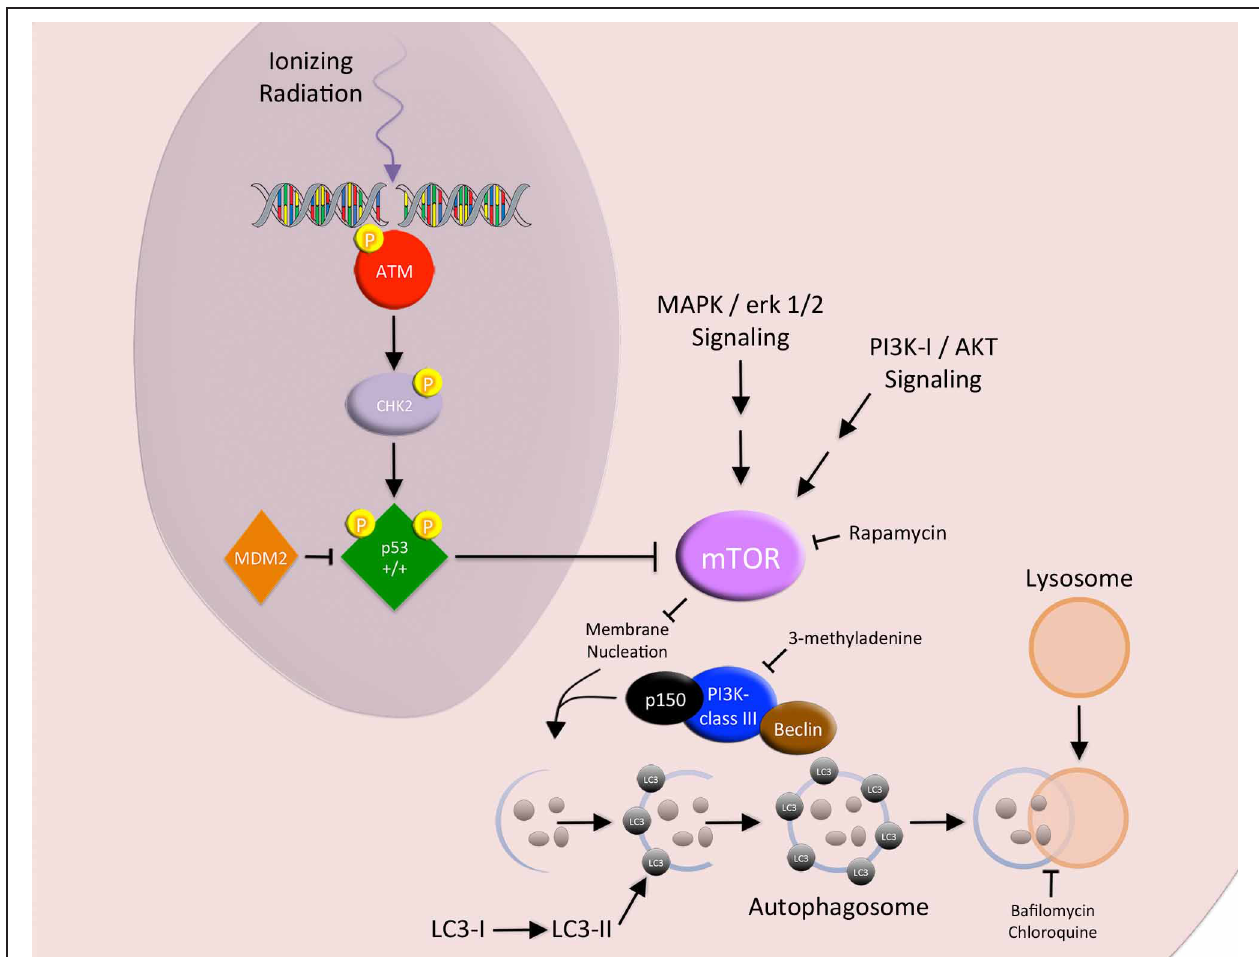
FIGURE 3 | Autophagy. The MAPK/erk 1/2 and PI3K-I/AKT signaling pathways block the promotion of autophagy via the activation of MTOR. IR-induced DNA damage activates p53, which acts as a negative regulator of MTOR. Upon initiation of autophagy, the phagophore is generated. A class III PI3K complex (Beclin, class III PI3K, and p150) recruits LC3 to the membrane